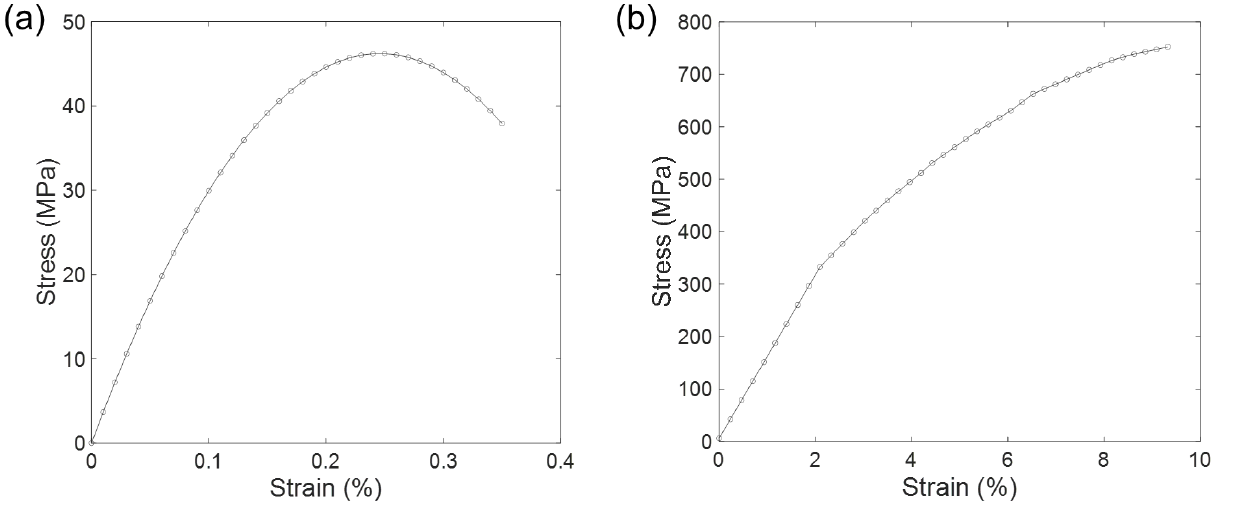
Figure 4. Idealized stress-strain curves used for FE simulations. ( a ) Compressive stress-strain curve for concrete and ( b ) tensile stress-strain curve for Fe-SMA bar.